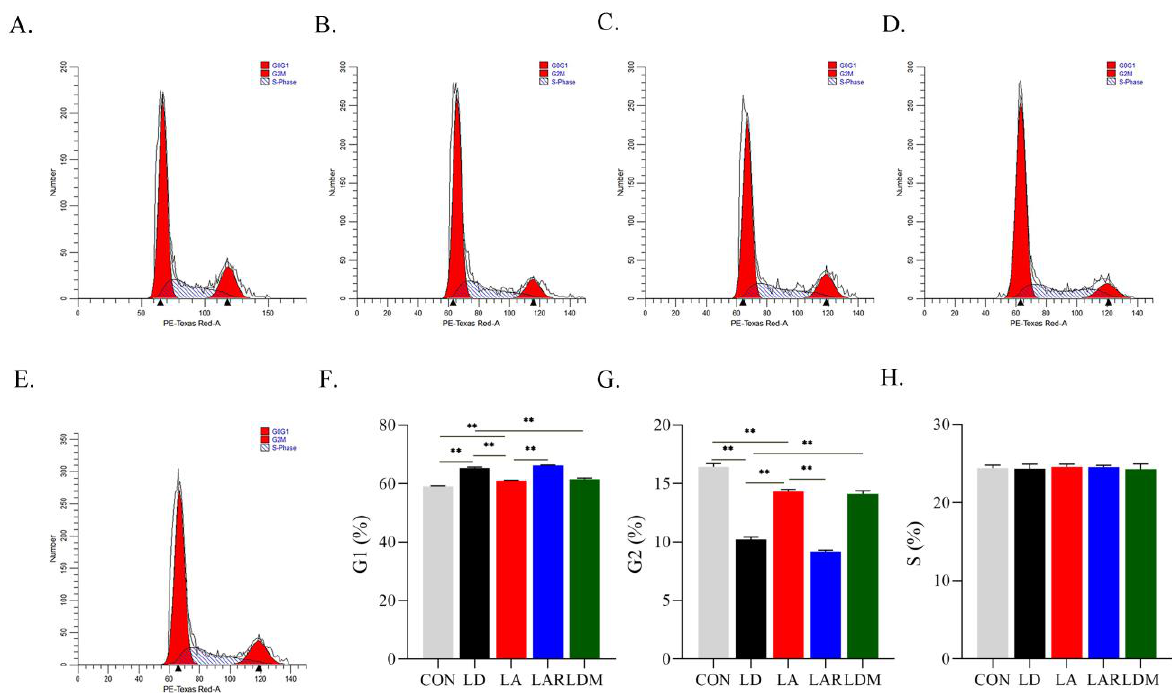
Figure 7. mTORC1 signaling pathway is involved in the regulation of SCs cycle by lysine. ( A ) CON; ( B ) LD; ( C ) LA; ( D ) LAR; ( E ) LDM; ( F ) G1 phase cell ratio (%); ( G ) G2 phase cell ratio (%); ( H ) S phase cell ratio (%), ** p < 0.01. The data shown represent mean ± SEM of three independent experiments ( n = 3).